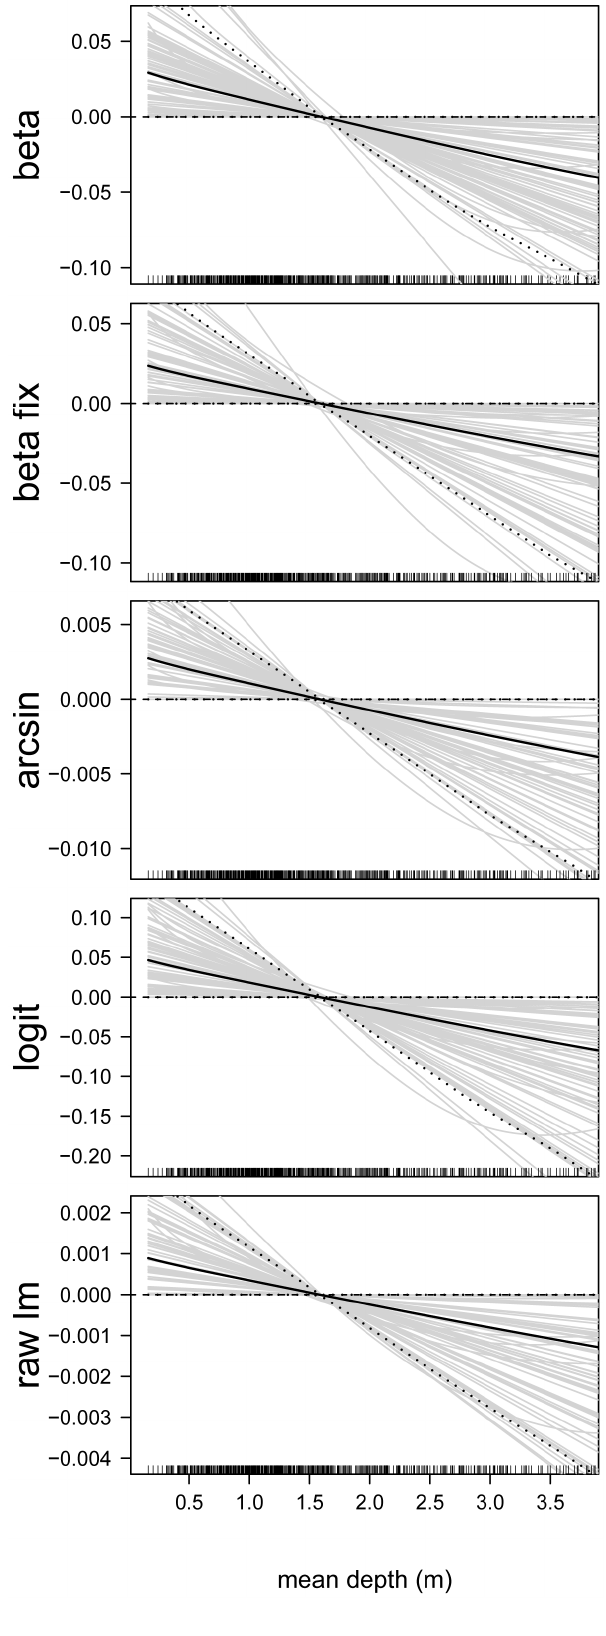
Figure 10. Function estimates for mean site depth. Analysis of the NLA Data. The five panels contain the function estimates for the mean depth at the sites (computed from 100 bootstrap samples). In case of beta regression, estimates present the effects of the depth on the mean parameter m . Black lines correspond to the mean and the 0.05 and 0.95 quantiles of the function estimates. For reasons of interpretability, the range of the x-axes was restricted to the lower 95% of the sample